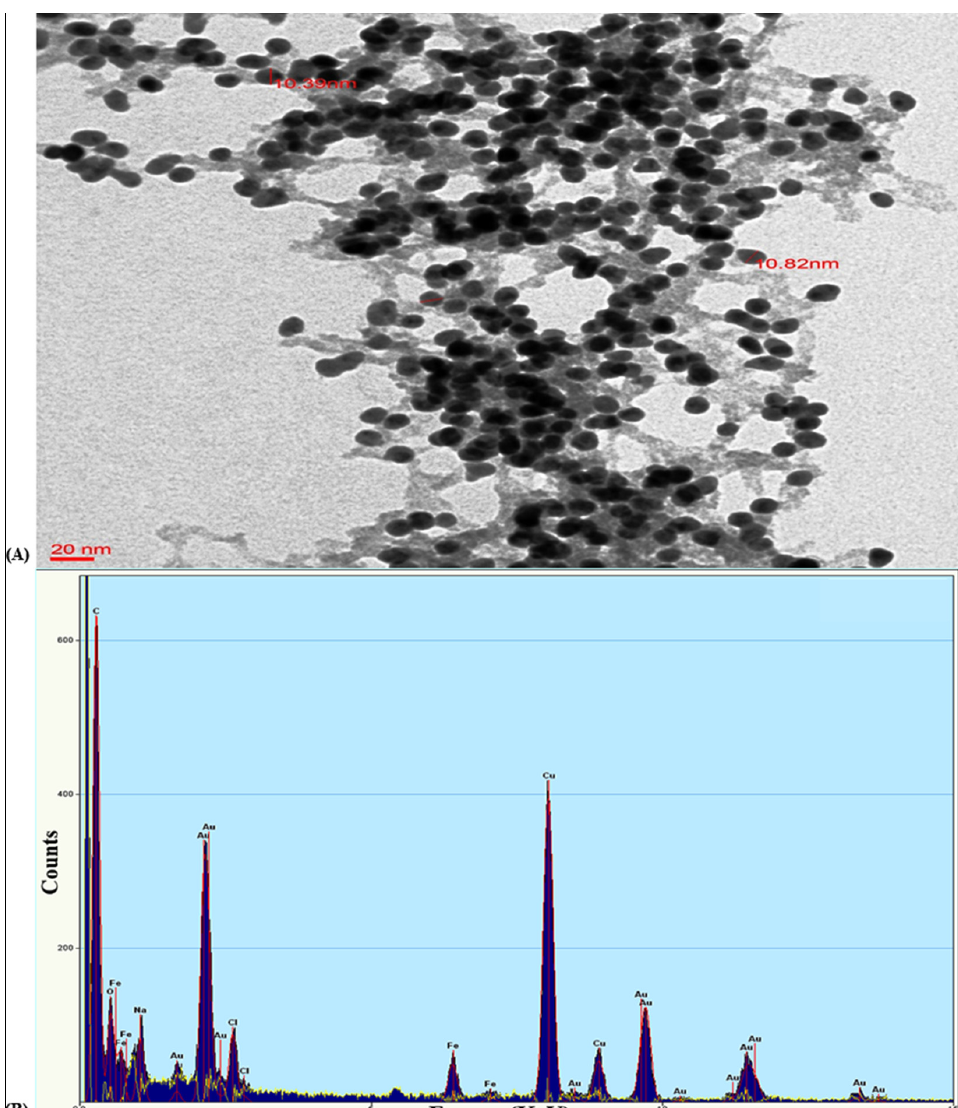
Figure 3. ( A ) Transmission electron micrograph of gold nanoparticle GNP023 and ( B ) EDX spectrum, confirming a sharp peak in the range of 1–5 keV, confirming the presence of gold. In both ( A ) and ( B ) EDX spectrum the largest peak is C (at about 0.5 KeV), second largest is Cu (at about 8 KeV), and third largest is Au (at about 2 KeV).